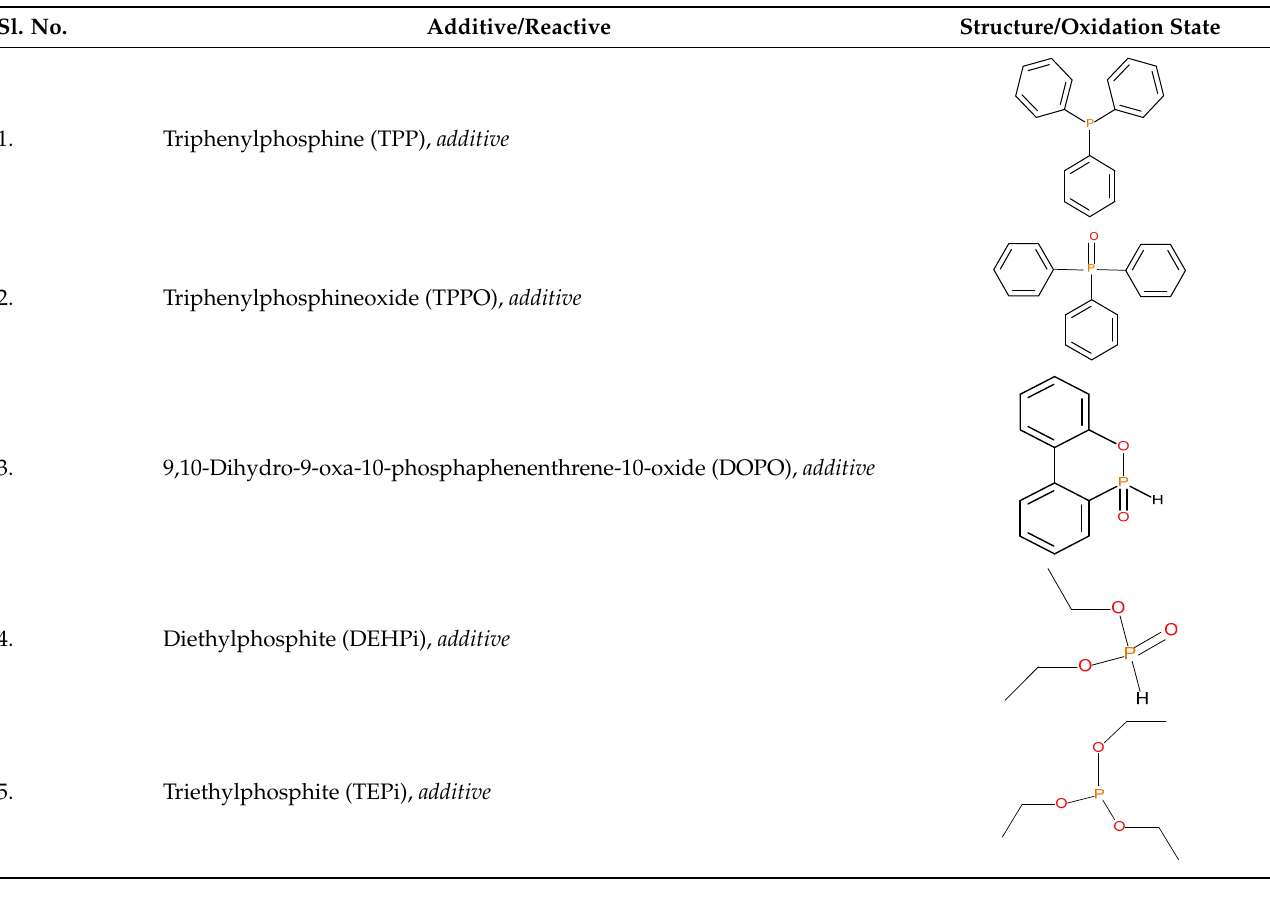
Table 1. Various additives and reactives used for the bulk polymerization of MMA and St. Sl. No.